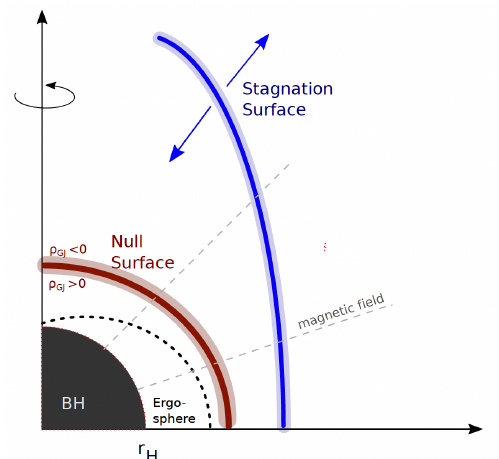
Figure 11. Illustration of possible locations of charge-deficient regions (gaps) around a rotating black hole in which UHECR acceleration could occur. The red line denotes the null surface across which the required Goldreich-Julian charge density ρ GJ changes sign, while the blue line delineates the stagnation surface from which stationary MHD flows